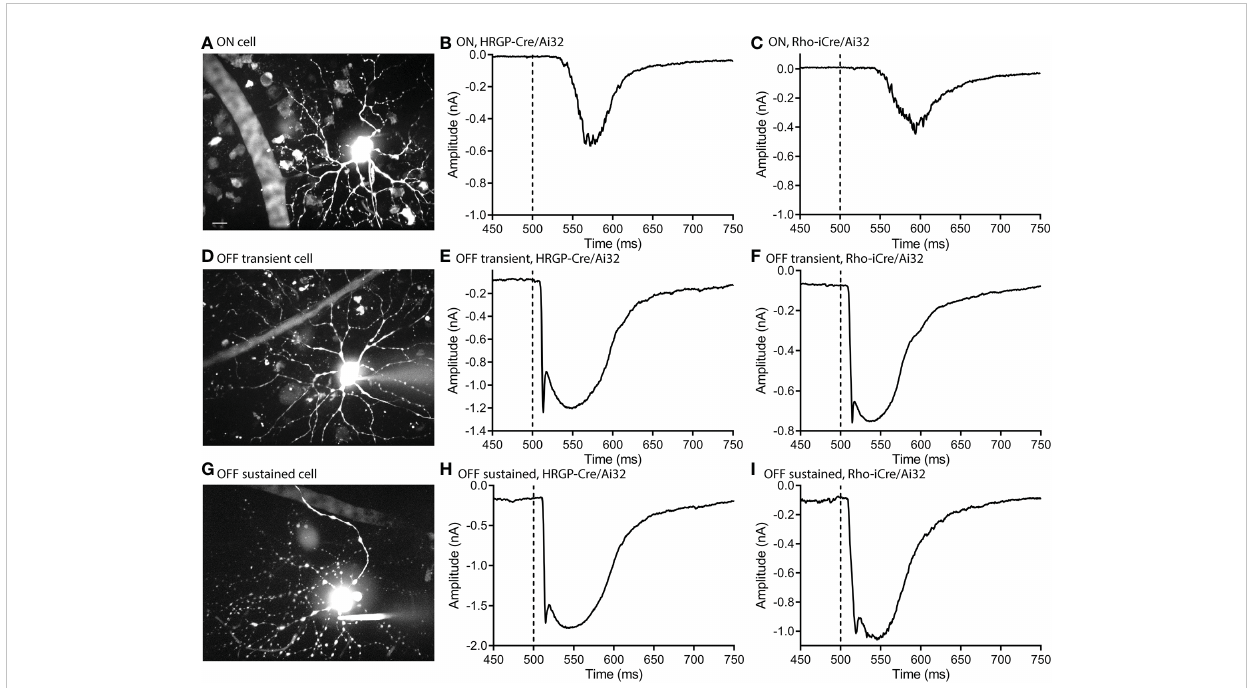
FIGURE 2 Optogenetic stimulation evoked similar fast inward currents in OFF transient and OFF sustained a retinal ganglion cells. ON cells showed slower inward currents. (A) Maximum intensity image of an ON a cell fi lled with Alexa 488. (B) Response of an ON a cell to optogenetic stimulation of cones showing a delayed inward current. (C) Response of an ON a cell to optogenetic stimulation of rods. (D) Maximum intensity image of an OFF transient a cell fi lled with Alexa 488. (E) Response of an OFF transient a cell to optogenetic stimulation of cones. (F) Response of an OFF transient a cell to optogenetic stimulation of rods. (G) Maximum intensity image of an OFF sustained a cell fi lled with Alexa 488. (H) Response of an OFF sustained a cell to optogenetic stimulation of cones. (I) Response of an OFF sustained a cell to optogenetic stimulation of rods. Experiments in this fi gure were conducted in the presence of strychnine (1 m M) and gabazine (10 m